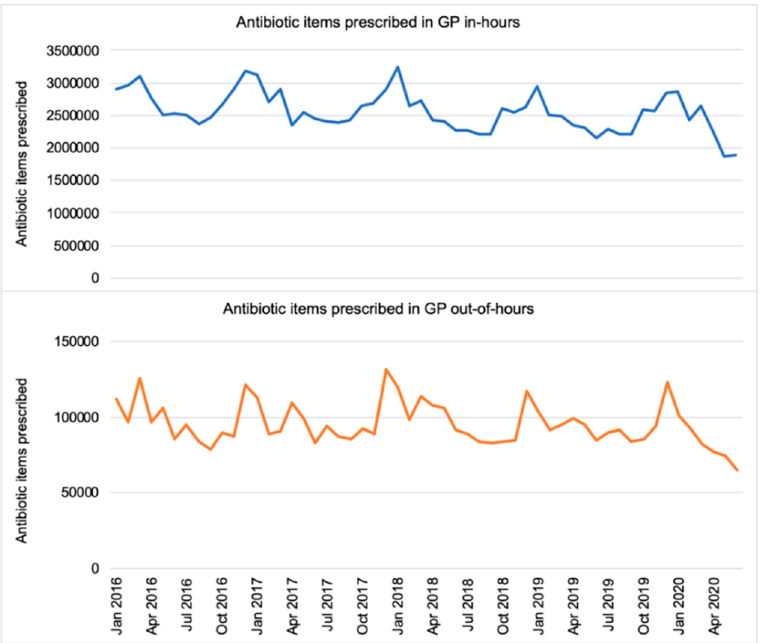
Figure 1. Total number of antibiotic items prescribed (England, 2016–2020). The proportion of broad-spectrum antibiotics to total antibiotic prescribing in OOH was consistently higher (10.1%, 95% CI: 10.0% to 10.2%, p < 0.05) compared with in-hours (8.7%, 95% CI: 8.6% to 8.8%, p < 0.05) (Figure 2). Before March 2020, the proportion of prescribed broad-spectrum antibiotics decreasing by 0.02% per month in GP IH settings (95% CI: − 0.03% to − 0.01%, p < 0.05). While a decrease of 0.02% per month was observed in the proportion of prescribed broad-spectrum antibiotics in OOH, this is insignificant ( p = 0.06). Figure 2. Percentage of broad-spectrum antibiotics prescribed (England, 2016–2020). 2.2. Respiratory Tract and Chest Infection Antibiotics in Out-of-Hours While the OOH prescribing of ciprofloxacin and cephalosporins remained stable within each year, the prescribing of co-amoxiclav, amoxicillin and doxycycline peaked in December every year, with the seasonality indicating a high use of amoxicillin in winter to treat respiratory tract infections (Figure 3). In 2020, the OOH use of co-amoxiclav and 0.0%2.0% 4.0%6.0%8.0% 10.0% 12.0% 14.0% J an 2016